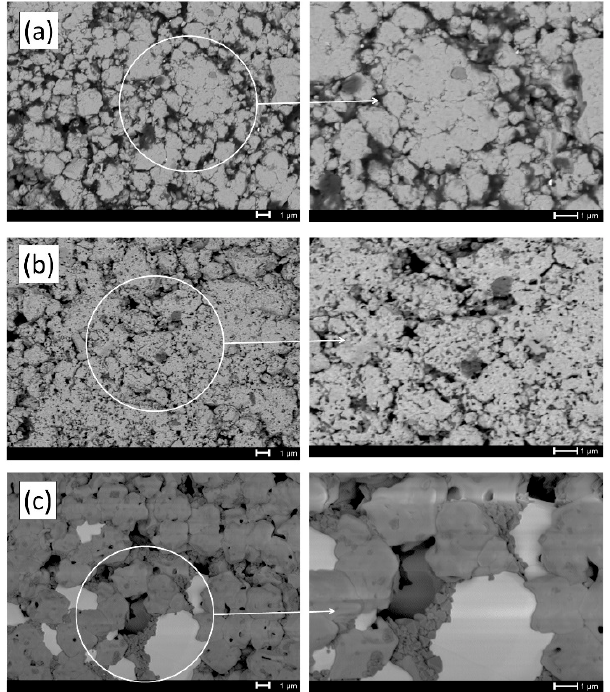
Figure 2. Scanning electron micrographs of samples: ( a ) x = 0, ( b ) x = 0.3 and ( c ) x = 0.5 annealed at 700 °C.